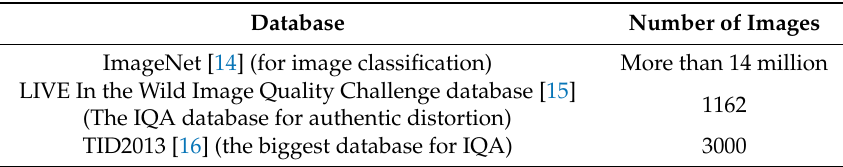
Table 1. Number of images in di ff erent database for image classification and image quality assessment